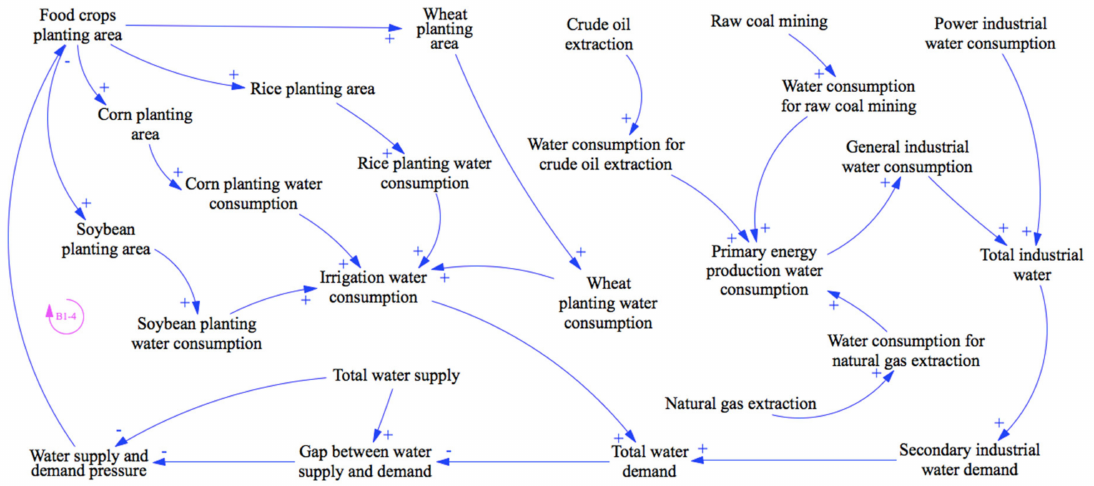
Figure 4. Causal loop diagram of the energy and food